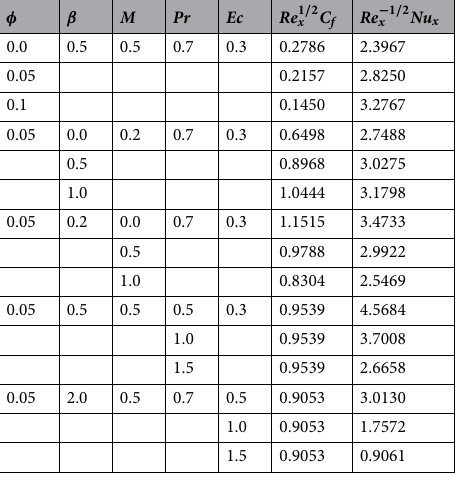
Table 4. Computational amounts of C f and Nu x for different choices of novel factors.